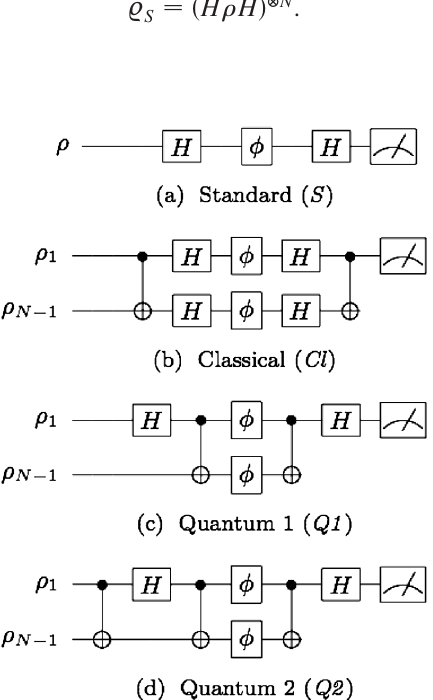
FIG. 1. The circuits for the four strategies considered in this is the control qubit and (cid:1) N (cid:1) paper are shown above. (cid:1) 1 N (cid:1) N (cid:1) 1 qubits. Initially all qubits are in i are the rest of the i ¼ 2 the same state, given in Eq. (1). The gates (in sequence from left to right) are a Hadamard gate H , a C-Not gate, the phase due to the unknown sample, and lastly, the meter represents the mea-